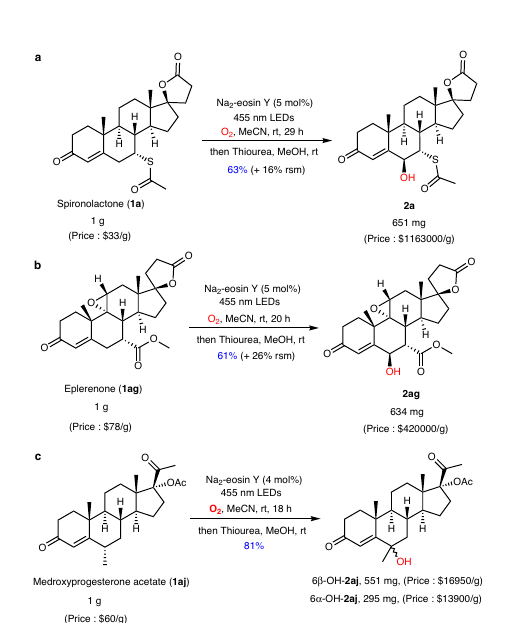
Fig. 3 | Modi fi cation of clinical drugs (10 examples of 9 carbon frameworks, which werenotincluded in Fig.2). Reaction conditions: enone(0.20mmol),Na 2 - eosinY(7mol%),O 2 balloon,andMeCN(10mL)atr.t.undertheirradiationof50W 455nmLEDsfor12h;thenthiourea(0.24mmol,1.2equiv.)andMeOH(10mL)were